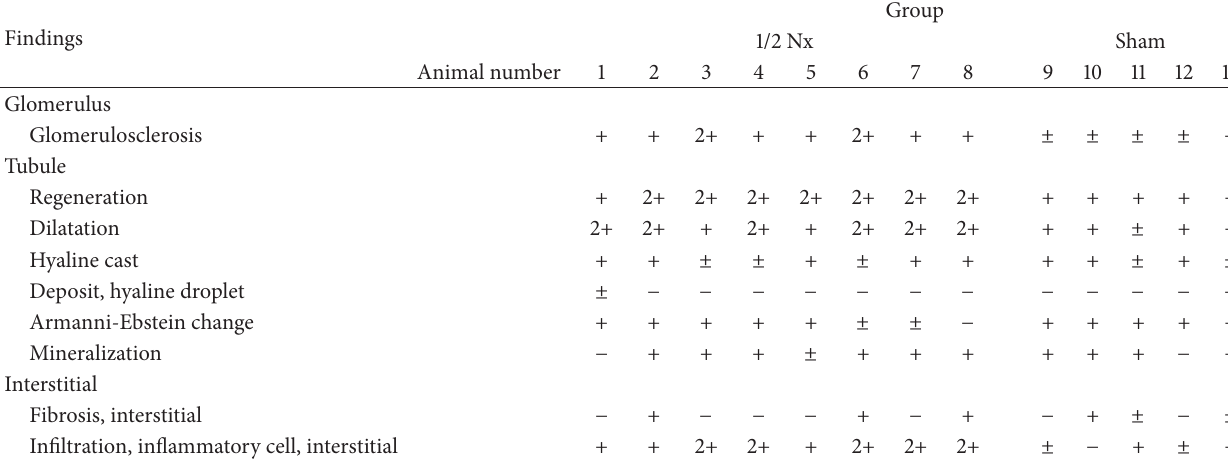
Table 1: Histopathological findings of kidney in sham group and 1/2 Nx group. Findings